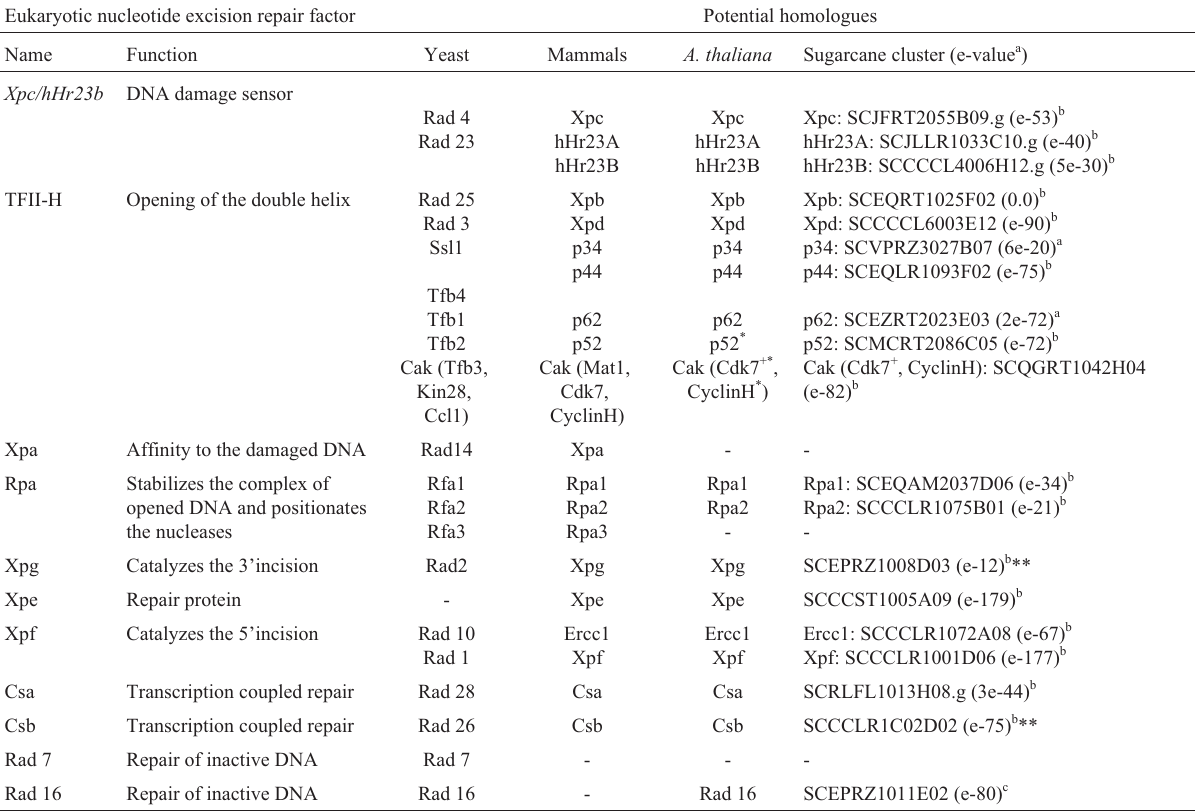
Table III - Nucleotide excision repair related proteins and their homologues in different organisms. Eukaryotic nucleotide excision repair